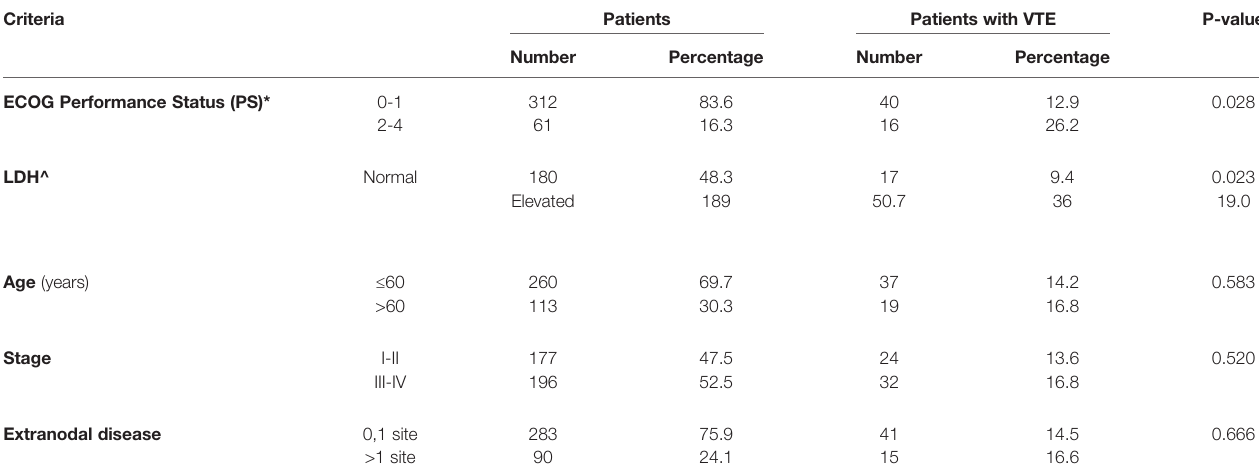
TABLE 3 | VTE rates according to components of the International Prognostic Index (IPI). Criteria